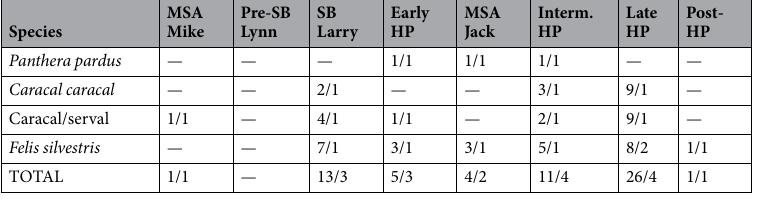
Table 1. Stratigraphic provenience of the felid remains per techno-complex in the Diepkloof Rock Shelter archaeosequence (data provided respectively in NISP and MNI; SB: Still Bay; HP: Howiesons Poort).